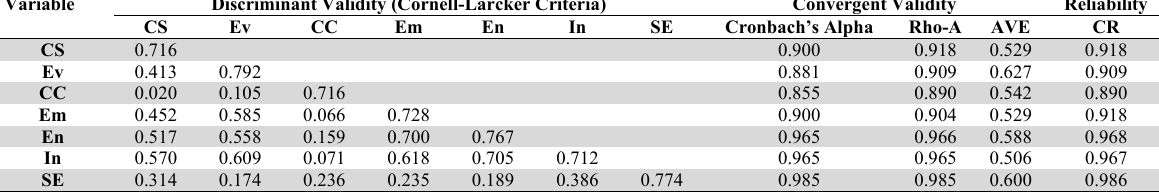
Validity and reliability of second-order citizen science models for a smart economy Variable Discriminant Validity (Cornell-Larcker